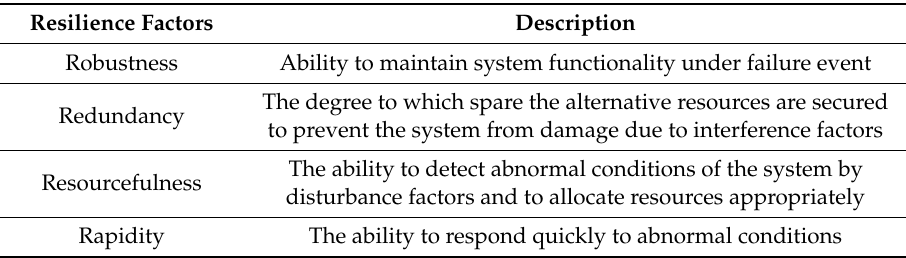
Table 1. Four elements of